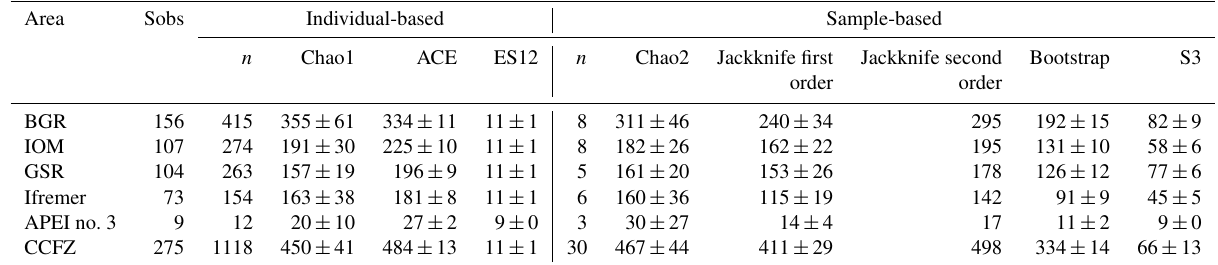
Figure 3. Correlation matrix between biotic and abiotic variables from sampled areas within the eastern CCFZ. Diagonal plots (a, b) show the distribution frequency of values for each variable. Panels below the diagonal plots (a, b) show the correlation plot between pairs of variables. Panels above the diagonal (a, b) plots show the Spearman coefficient correlations between pairs of variables. Abundance, richness and nodule density per box core are shown in (a) and average biotic and abiotic variables per area are shown in (b) . Eastern POC values provided by Volz et al. (2018); NE Pacific POC values were estimated in the present study. ∗ indicates p< 0 . 05, ∗∗ ” p< 0 . 01 and ∗∗∗ p< 0 . 001. Table 3. Observed species richness (Sobs) and estimators of species richness for each sampled area and for the eastern CCFZ. Area Individual-based